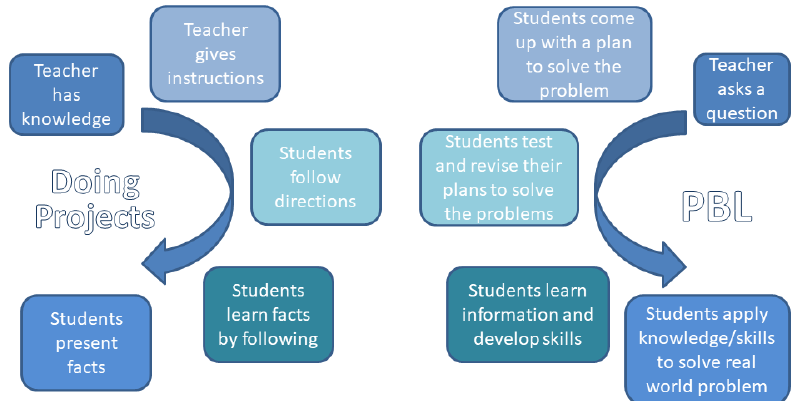
Figure 6. Students’ role in PBL compared to classical